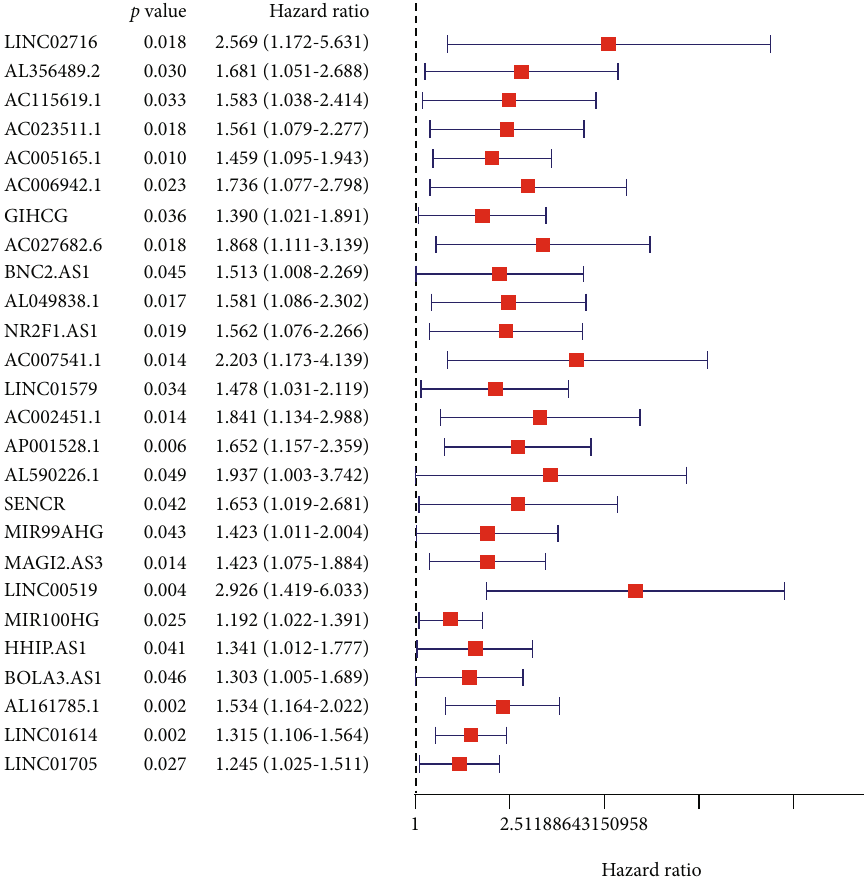
Figure 2: 26 independent prognostic predictor lncRNA signatures with di ff erent expressions of